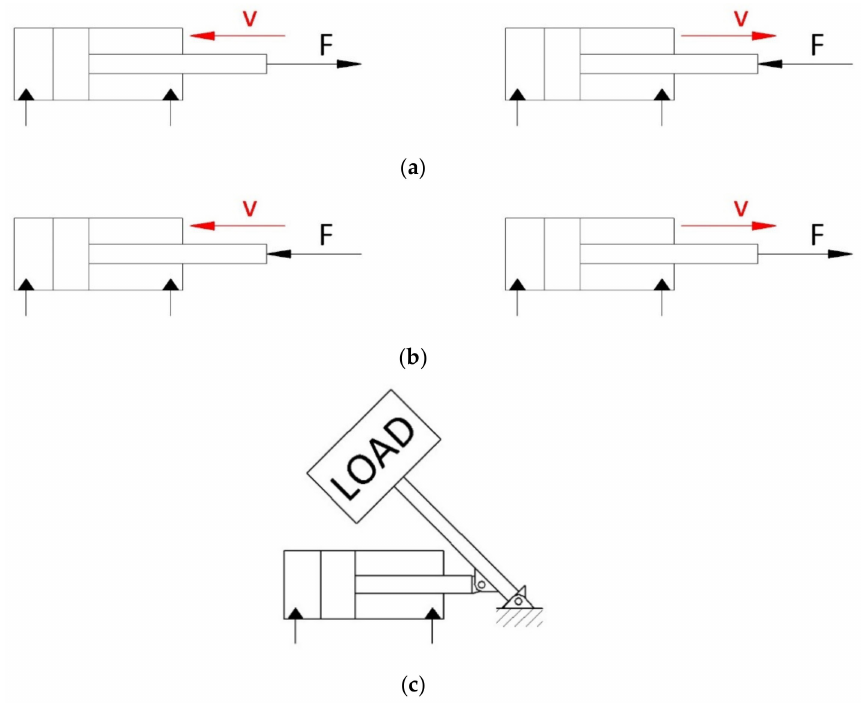
Figure 4. Different load conditions of double-acting actuator: ( a ) passive load; ( b ) active load; ( c ) variable